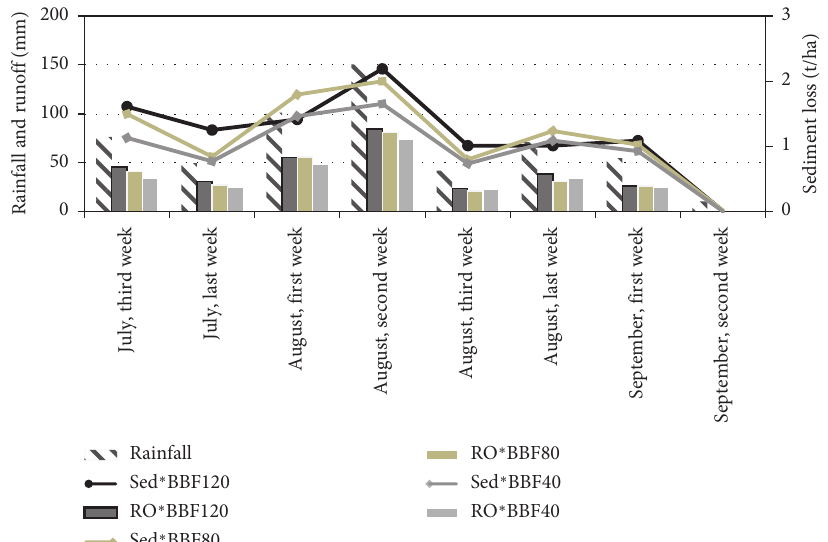
Figure 5: The periodical behavior of rainfall, runoff, and sediment yield for the year 2018 growing season (RO: runoff; Sed: sediment).